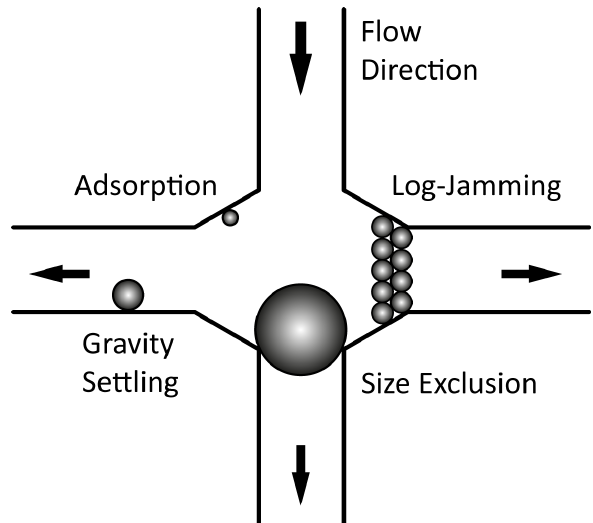
Figure 3. Mechanisms of nanoparticles’ entrapment in porous media. Figure adapted from Ref.